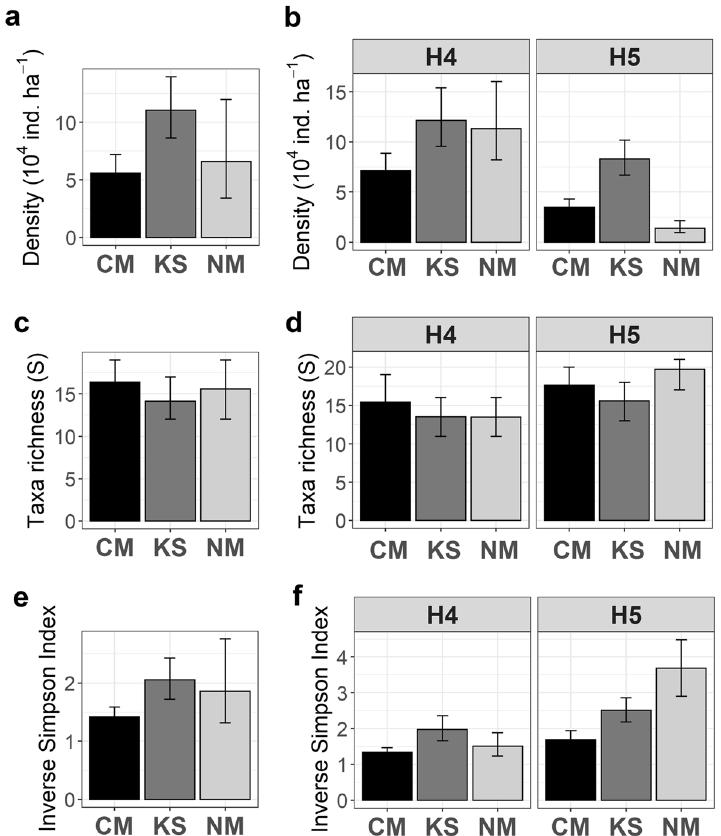
Figure 2. Regional variations in ( a ) megabenthos density (ind. ha −1 ), ( c ) taxa richness S (in ca. 1,000 specimens), ( e ) 1/Simpson index D (in ca. 1000 specimens), and local variations in ( b ) megabenthos density (ind. ha −1 ), ( d ) taxa richness S (in ca. 1000 specimens), and ( f ) 1/Simpson index D (in ca. 1,000